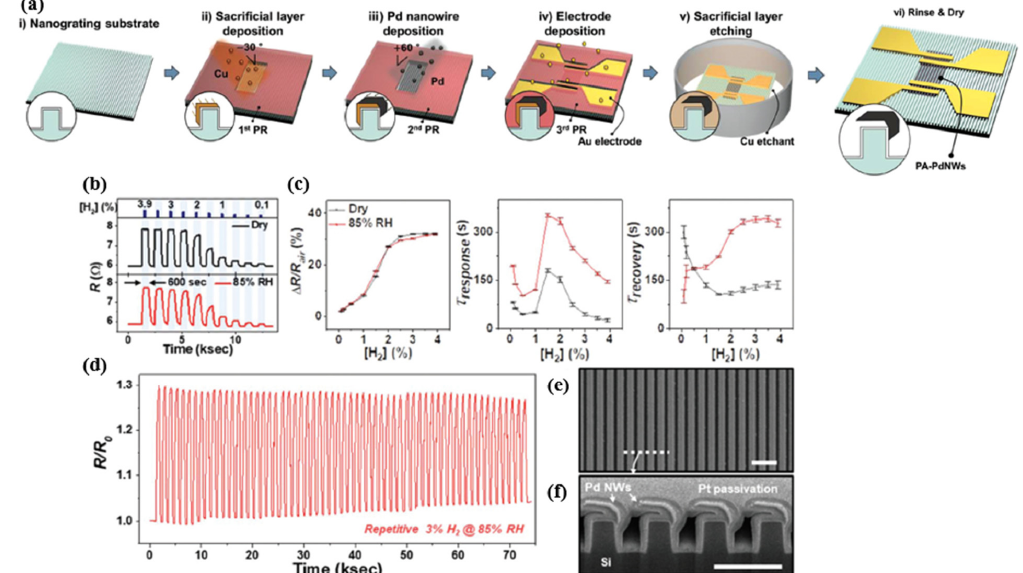
Figure 11. ( a ) Schematic illustration of the fabrication of partially anchored Pd nanowires (PA-PdNW) H 2 sensor. (Insets: a cross-sectional view of a single nanograting pattern.). ( b ) Measured responses of the PA-PdNW sensors (tw ∼ 20 nm, la ∼ 50 nm, wire length equals 20 µ m, the nanowire array width equals 30 µ m) at varying H 2 concentrations and different humidity levels. ( c ) The performance of the PA-PdNW sensors extracted from ( b ), namely the gas response, response time and recovery time, respectively. ( d ) Response to repetitive 3% H 2 exposures at 85% relative humidity. ( e ) Top-view (scale bar equals to 1 μ m) and ( f ) cross-sectional (scale bar = 500 nm) SEM images of PA-PdNW after over 50 times repetitive 3% H 2 exposures of at 85% relative humidity (single nanograting pattern) [66]. Copyright (2019), with permission from Royal Society of Chemistry.